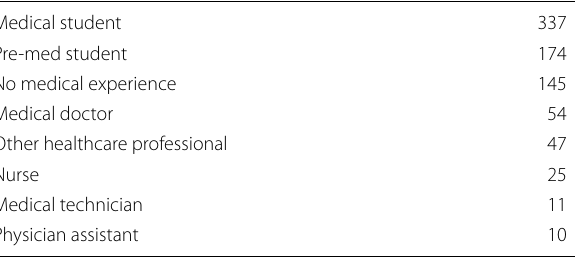
Table 1 Observers divided by expertise